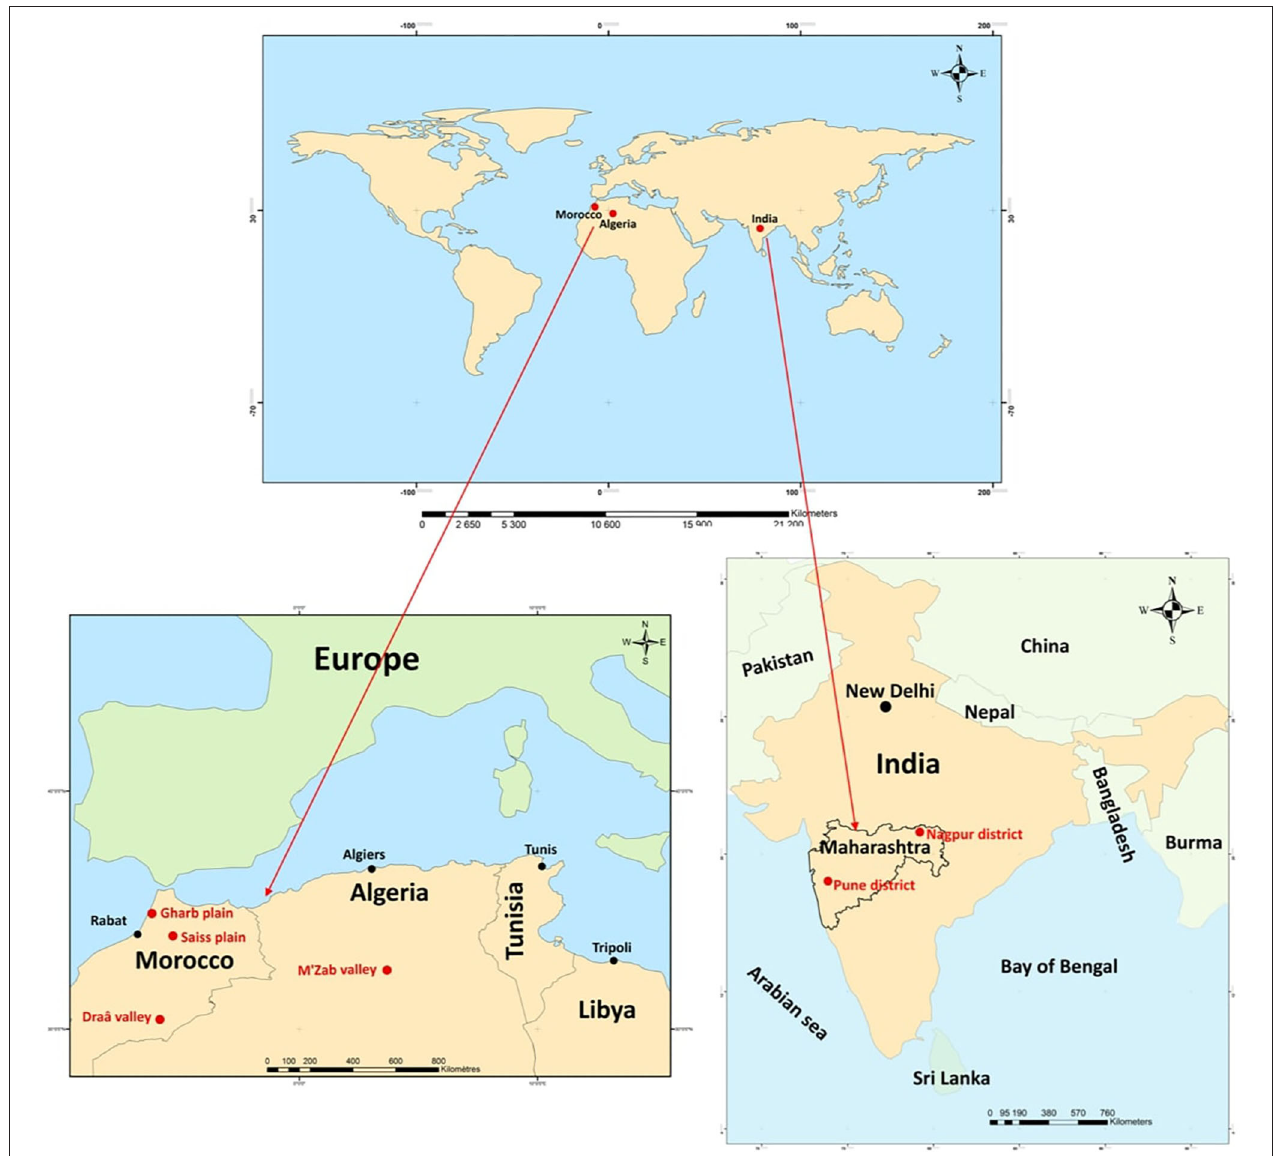
FIGURE 1 | Map of study areas in Algeria, India, and